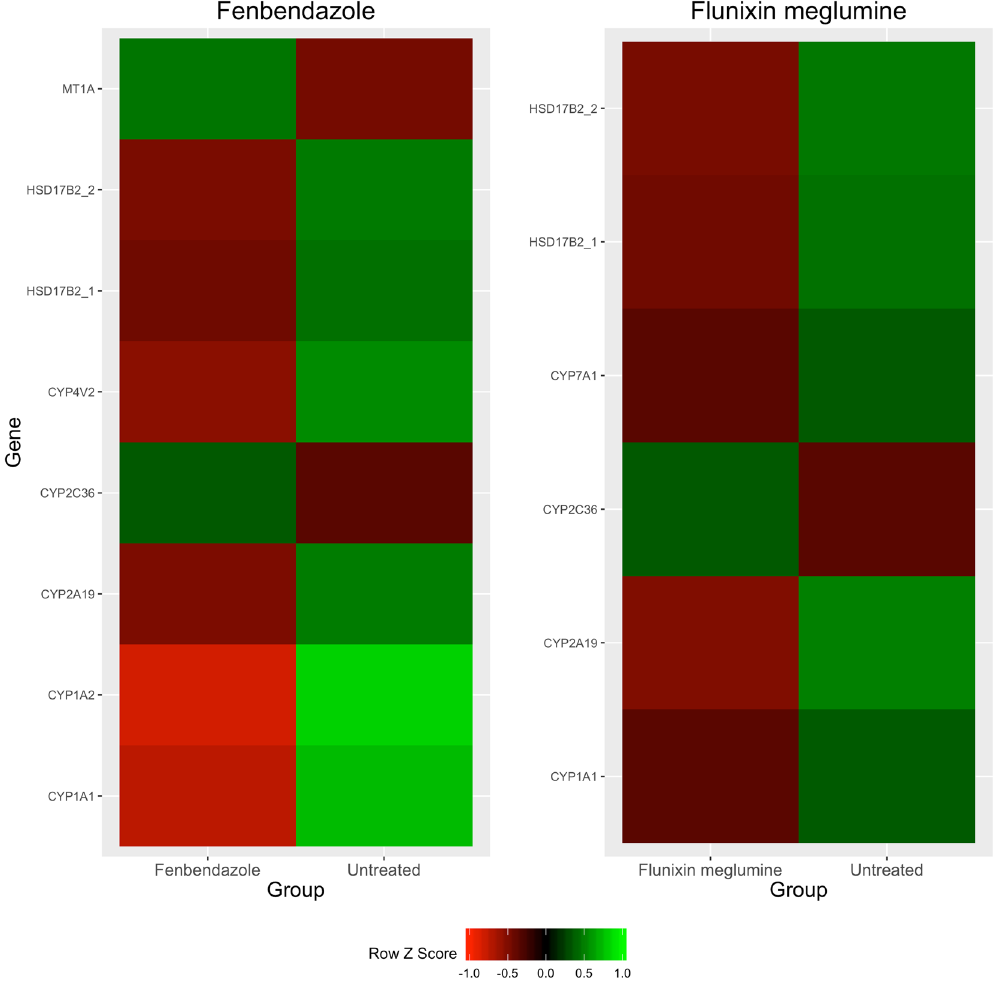
Figure 2. Expression profiles of genes with known Phase I and II drug metabolism functions and highly significant (FDR < 0.0001) transcript differences across animals administered a drug versus